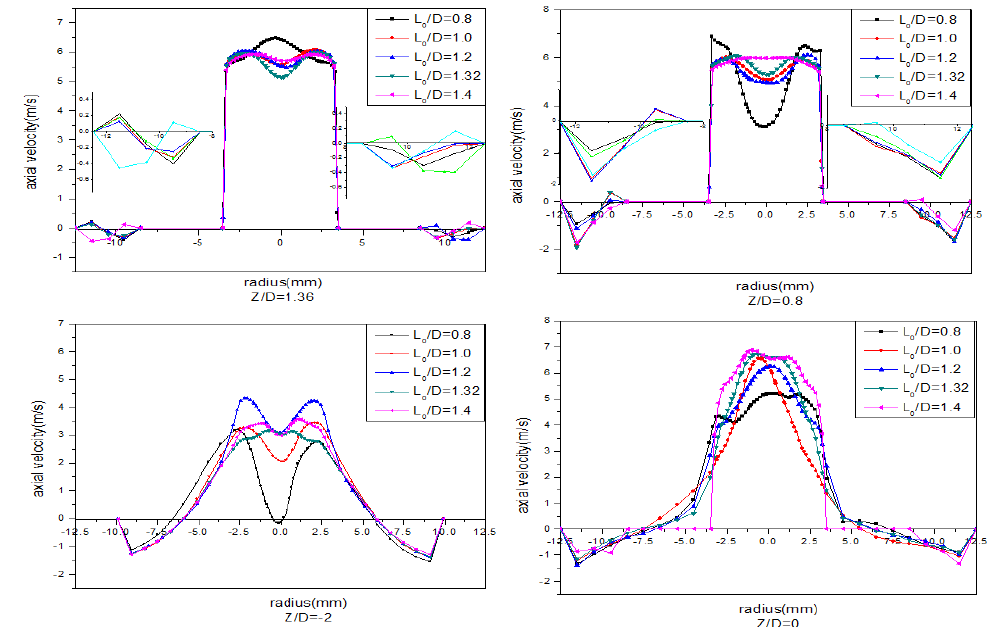
Figure 6. Radial velocity cloud figure of mini-hydrocycloness with different vortex finder depth.